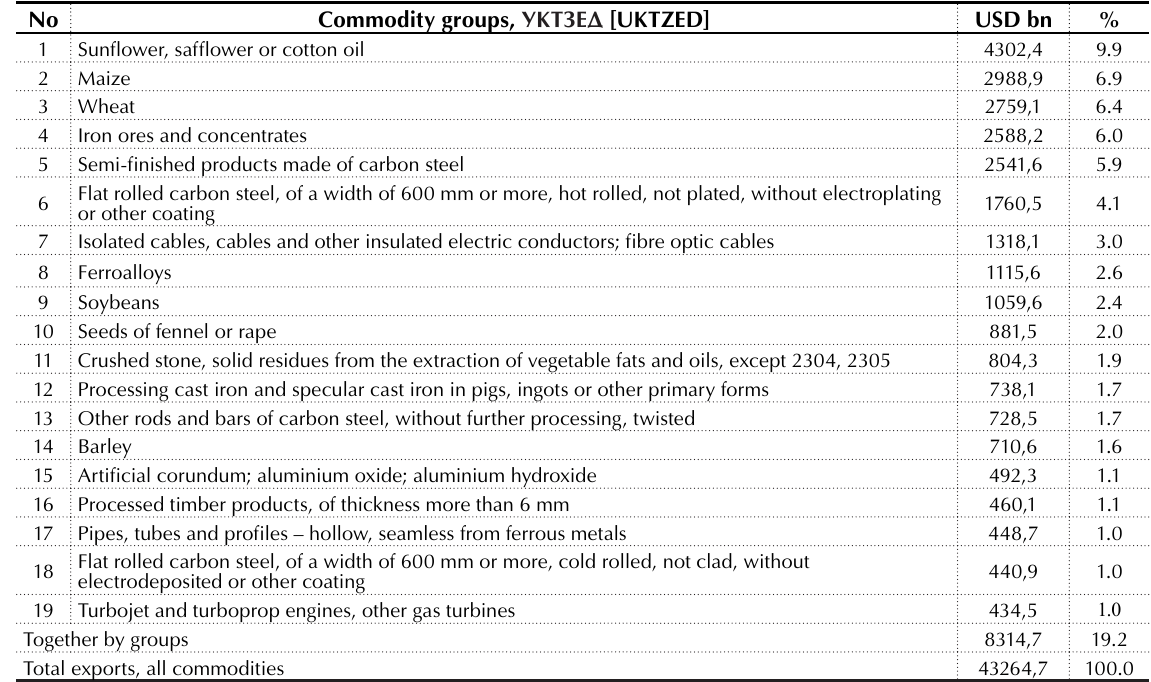
Table 4. Products with the largest share of exports from Ukraine in